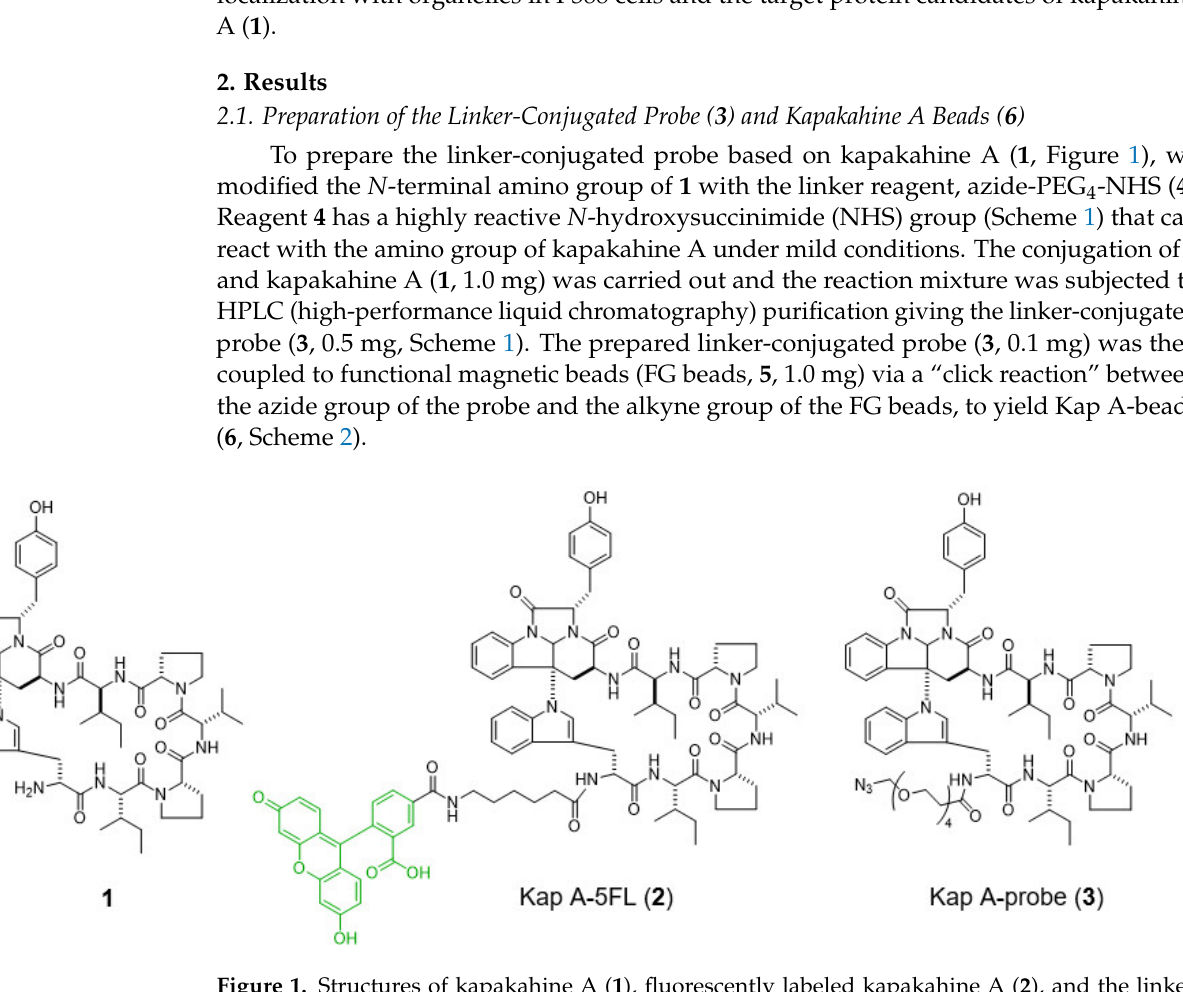
Figure 1. Structures of kapakahine A ( 1 ), fluorescently labeled kapakahine A ( 2 ), and the linker- conjugated probe ( 3 ).